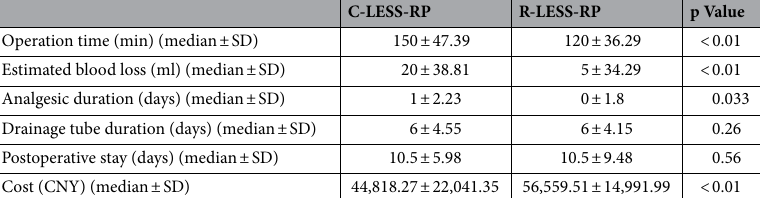
Table 2. Perioperative outcomes of patients with C-LESS-RP and R-LESS-RP (t-test or Mann–Whitney test). C-LESS-RP conventional laparoendoscopic single-site radical prostatectomy, R-LESS-RP Robot-assisted laparoendoscopic single-site radical prostatectomy, SD standard